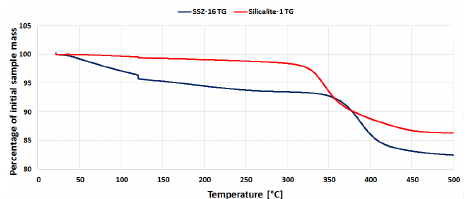
Figure 10. Examples of TG curves - percentage of the sample mass based on initial mass vs. temperature; red - silicalite-1 templated with TPA + ; blue - SSZ-16 templated with Et 6 -diquat-5 2+